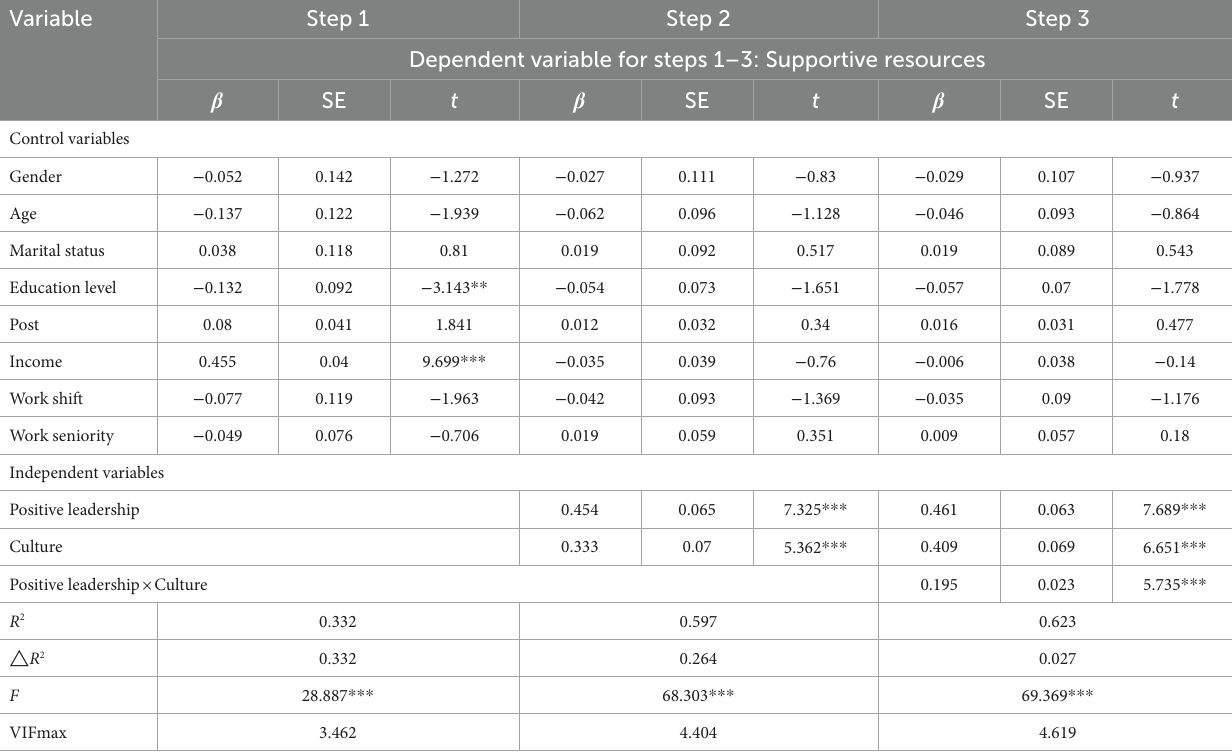
TABLE 9 Moderating effect of culture on the relationship between positive leadership and supportive resources.